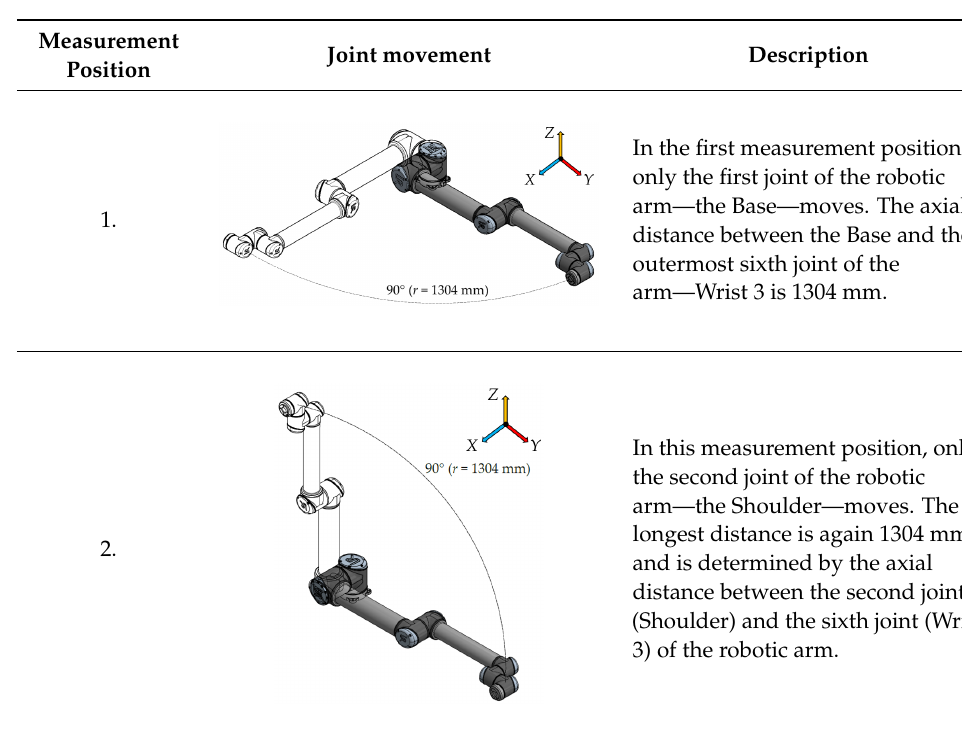
Table 1. Percentage velocities from maximum velocity for individual